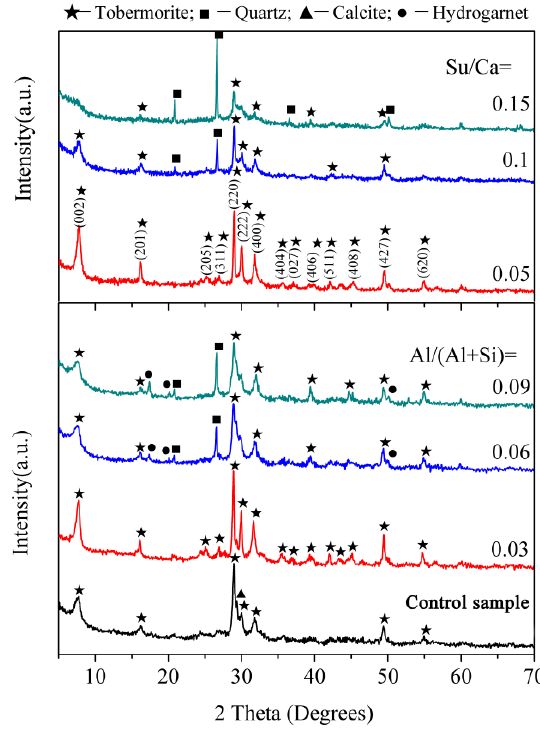
Figure 1. XRD patterns of the synthesized products.